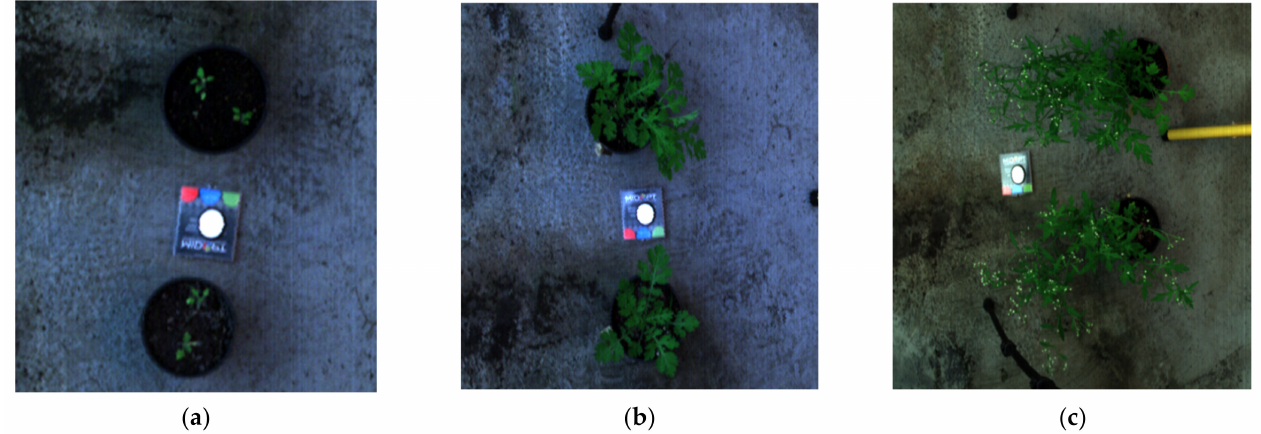
Figure 5. Hypercubes of the three parthenium weed growth stages ( a ) seedling ( b ) rosette ( c ) flowering